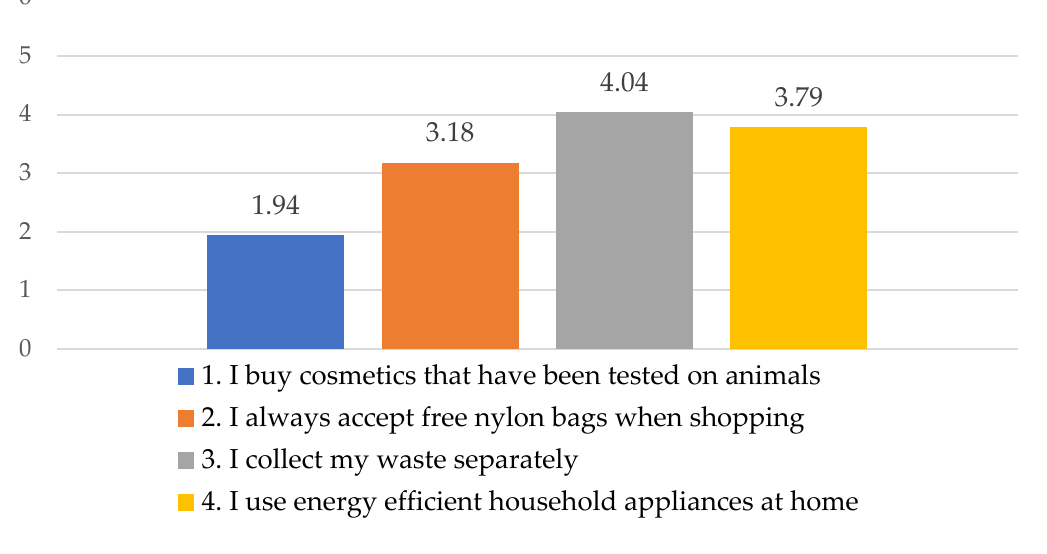
Figure 8. Average perception of students according to how typical each statement is for them.